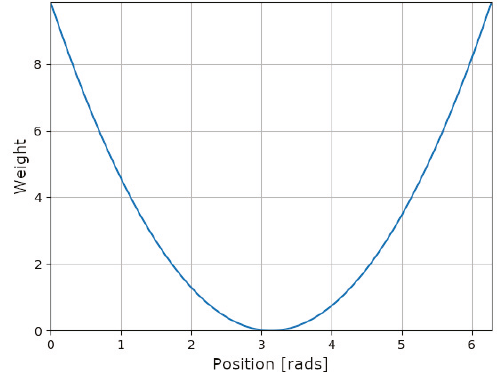
Figure 9. Weighting function for elevation.